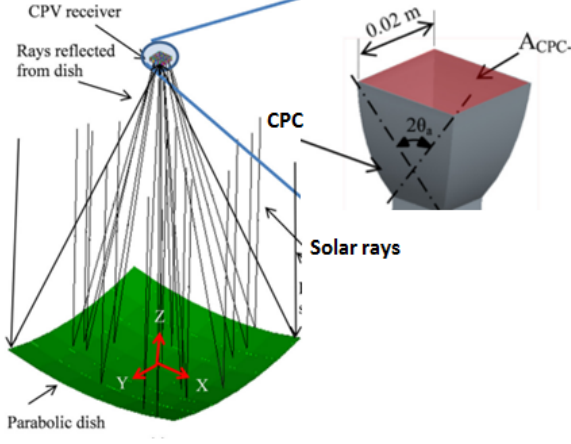
Figure 39. Optical system proposed by Lokeswaran et al. [73] composed of a square parabolic mirror and reflective CPCs. Reprinted from S. Lokeswaran et al., Design and analysis of dense array CPV receiver for square parabolic dish system with CPC array as secondary concentrator, Solar Energy 2020, 199, 782–795, with permission from Elsevier.